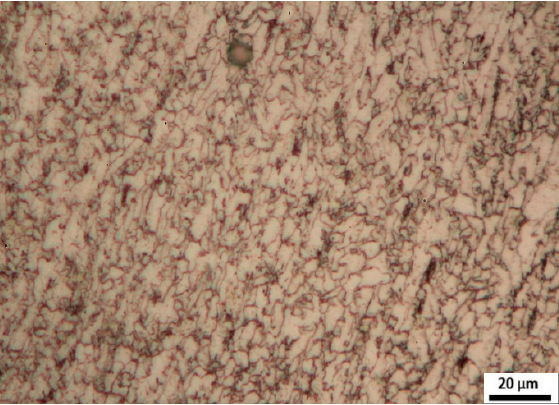
Figure 2. S500MC HSLA steel microstructure consisting of ferrite (light areas) and pearlite (dark